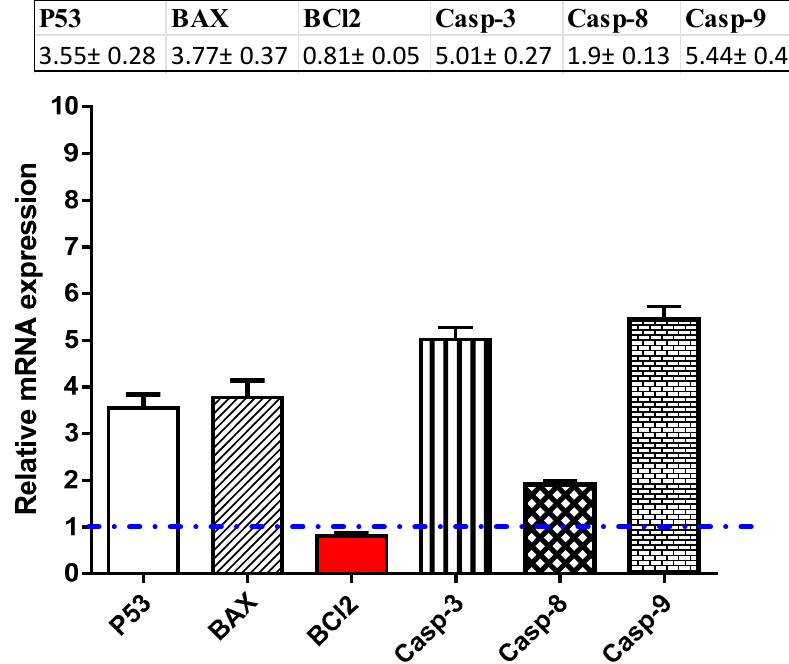
Figure 6. RT-PCR analysis of the apoptosis-related genes was performed after the MCF-7 cells were treated with compound 1 (IC 50 = 25.92 µM, 48 h).